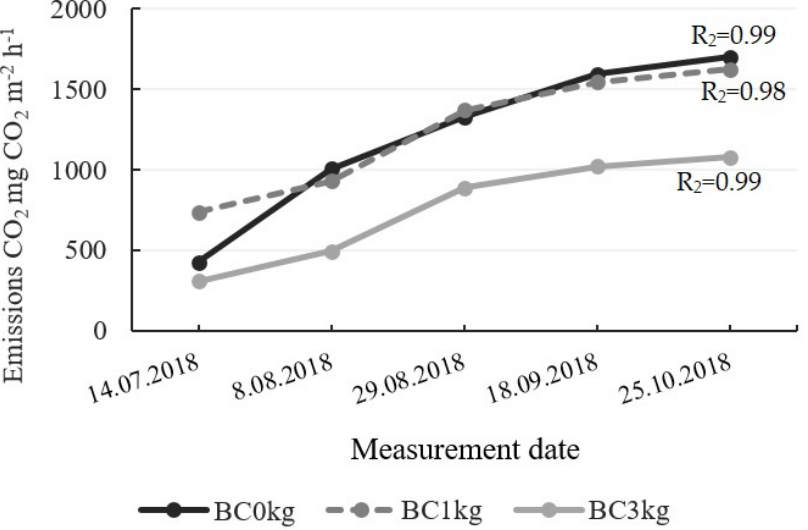
Figure 3. Cumulative CO 2 flux in the area without biochar (BC0), from 1 kg/m 2 (BC1kg), and from 3 kg/m 2 (BC3kg) for the growing season of